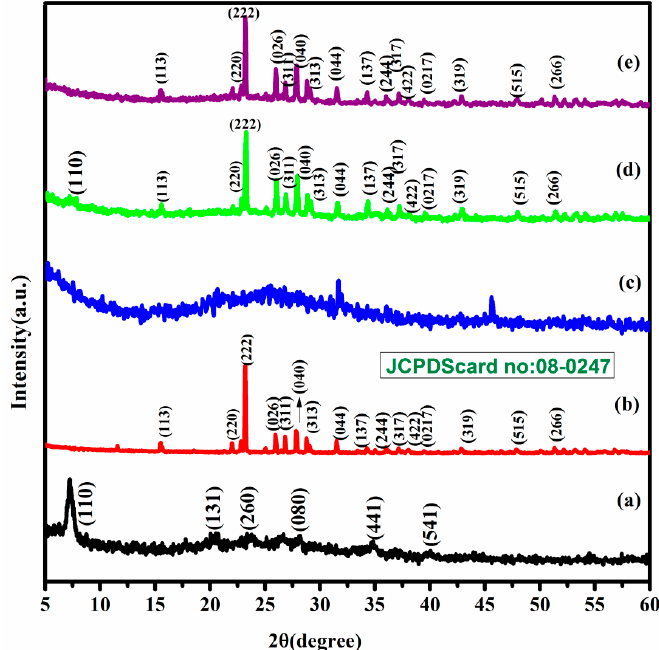
Figure 1. Patterns of ( a ) sieved sepiolite (SvSp), ( b ) pure sulfur (PS), ( c ) Polyaniline (PAni), ( d ) sulfur/sieved sepiolite/PAni (S/SvSp/PAni), ( e ) sulfur/post ‐ treated sepiolite/PAni(S/PTSp/PAni). The XRD patterns of SvSp, pure sulfur, PAni and composite materials such as S/PTSp/PAni and